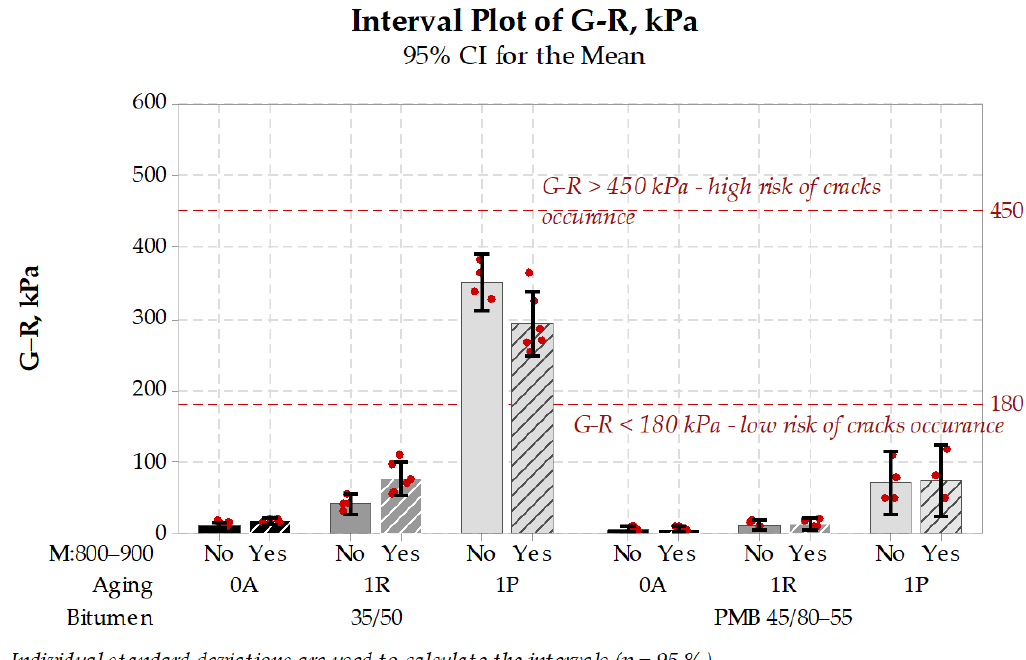
Figure 17. Interval plot of G-R parameter of bitumen obtained in different aging conditions (the higher, the worse).